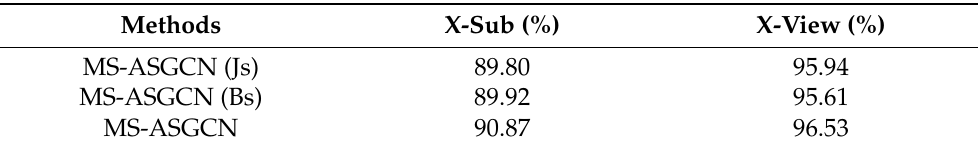
Table 6. Experimental results on the NTU-RGB+D dataset with different input modalities. Js: Joint stream and Bs: Bone